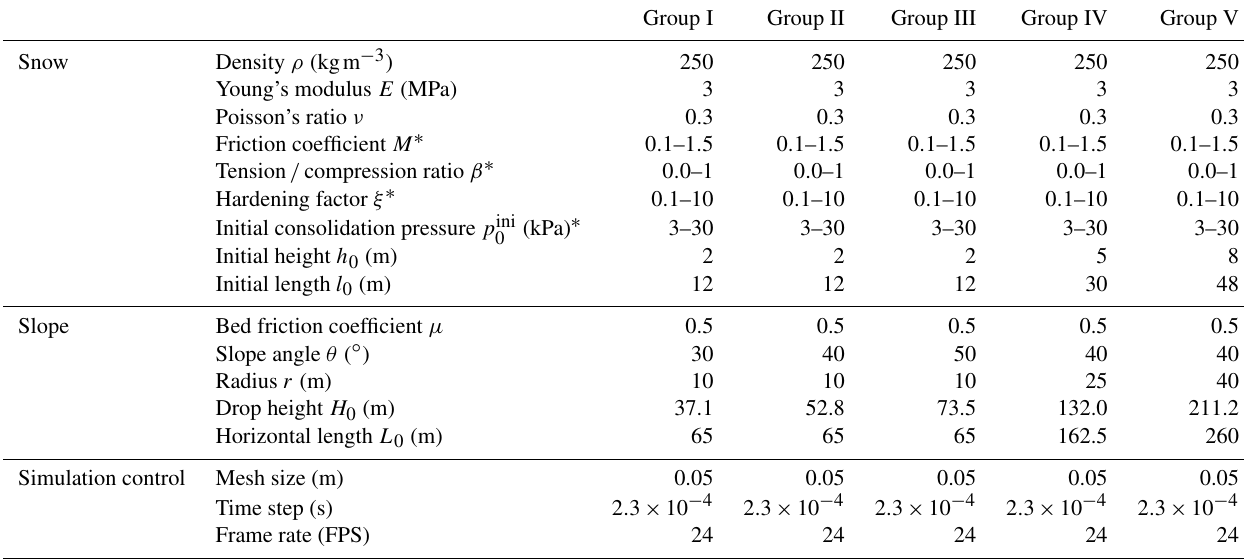
Table 1. Parameters adopted in the MPM simulations of snow avalanches on ideal